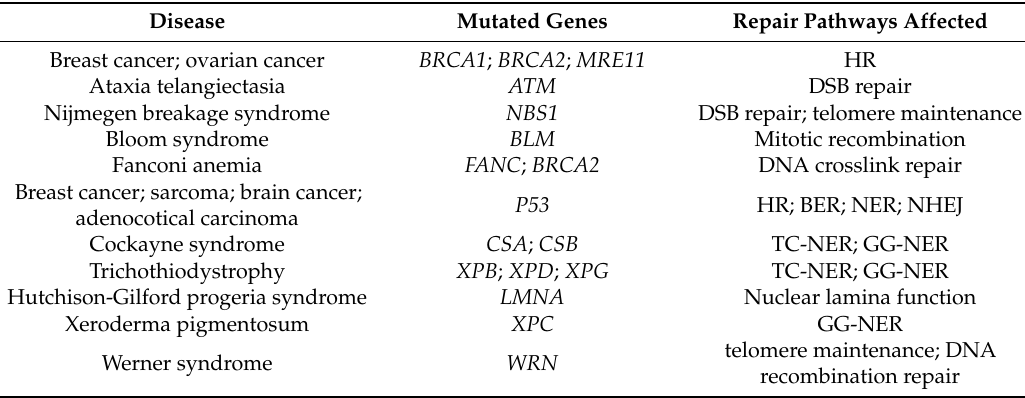
Table 1. A list of age-associated diseases carrying defects in genome maintenance. Disease Mutated Genes Repair Pathways Affected Breast cancer; ovarian cancer BRCA1 ; BRCA2 ; MRE11 HR Ataxia telangiectasia ATM DSB repair Nijmegen breakage syndrome NBS1 DSB repair; telomere maintenance Bloom syndrome BLM Mitotic recombination Fanconi anemia FANC ; BRCA2 DNA crosslink repair Breast cancer; sarcoma; brain cancer; P53 HR; BER; NER; NHEJ CSA ; CSB Nuclear lamina function Xeroderma pigmentosum XPC GG-NER telomere maintenance; DNA Werner syndrome WRN recombination